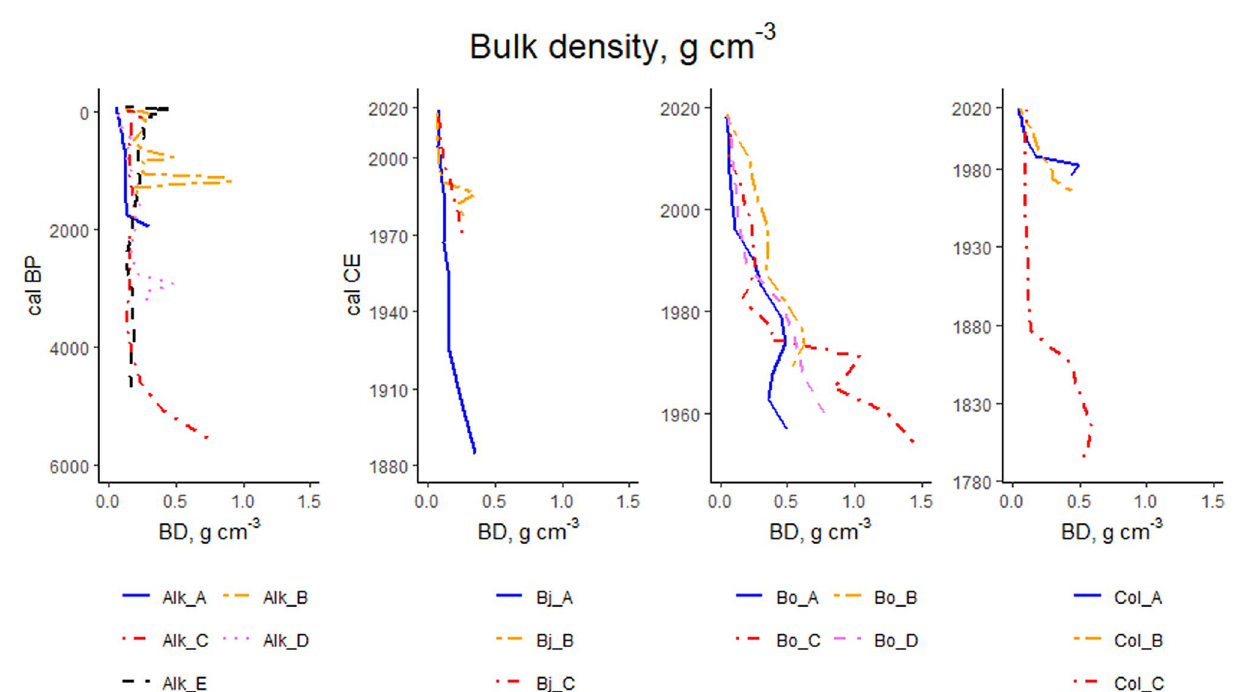
Figure 8. Bulk density, g cm -3 at different soil layers. Each panel represent different study site. For the study site Alkhornet (Alk), age is presented as calibrated Before Present (cal BP) while for Bjørndalen (Bj), Bolterdalen (Bo) and Colesdalen (Col) ages are presented as calibrated Common Era (cal,